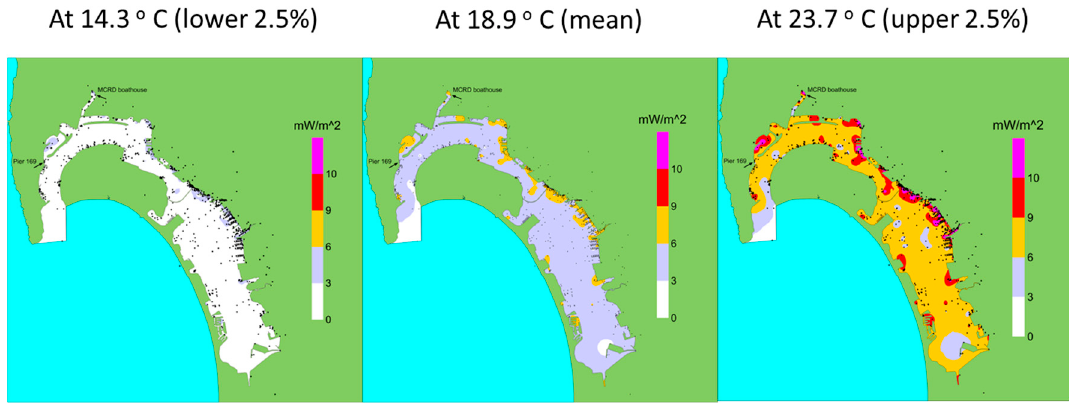
Figure 2. Predicted MFC power potential in San Diego Bay from a 1 m 2 anode and ~700 known sediment TOC concentrations (black dots) and seasonal water temperatures.